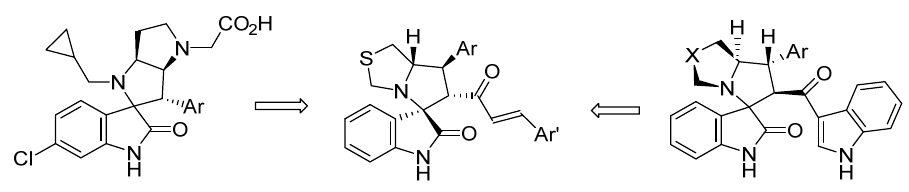
Figure 5. Spiroindolinones design in the work [41].